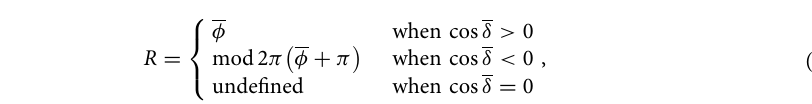
S e (cid:30) can reach. Note that only the plane S 1 = 0 (cid:31) S e (cid:30) as the incoherent (cid:31) 0 when cos δ > 0 ( b ) and when cos δ < 0 ( c =